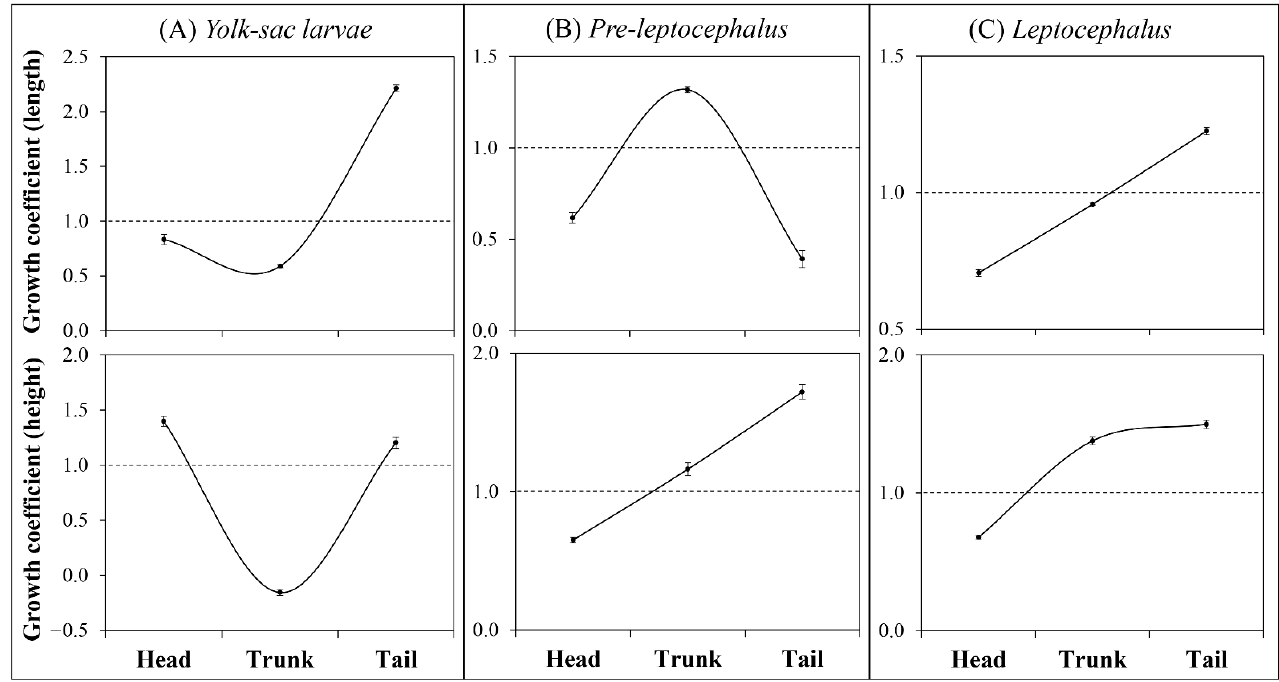
Figure 8. Growth coefficients of head, trunk, and tail parts in larval stages of Anguilla japonica . ( A ) Yolk sac larval stage: 3.23–6.85 mm TL. ( B ) Pre-leptocephalus stage: 6.85–15.31 mm TL. ( C ) Leptocephalus stage: 15.31–60.06 mm TL. Values are means ± SD. Abbreviation: TL, total length.